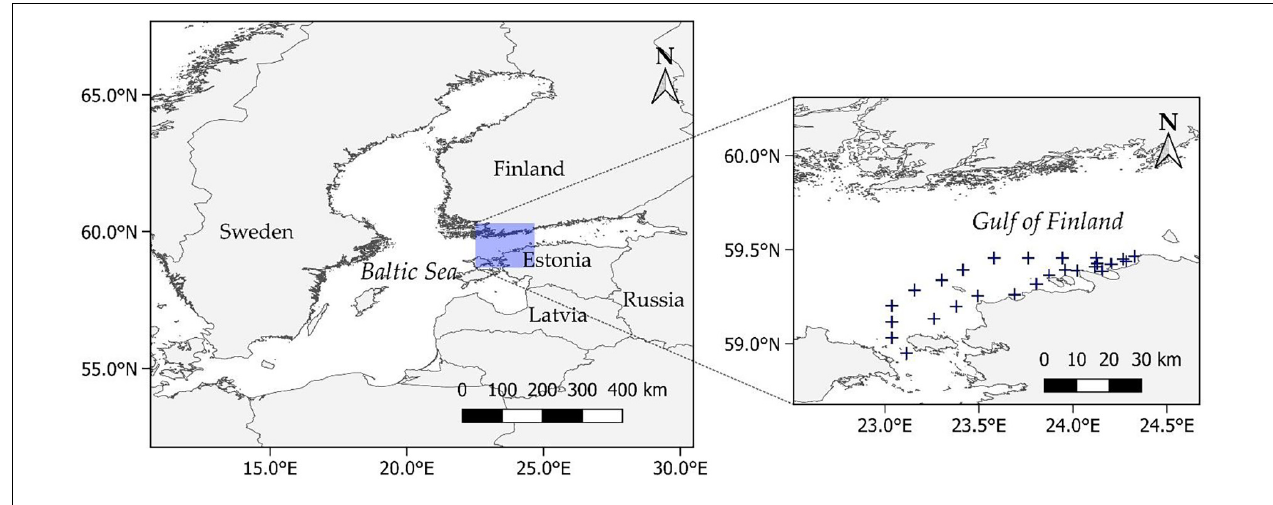
FIGURE 1 | Study area and location of sampling